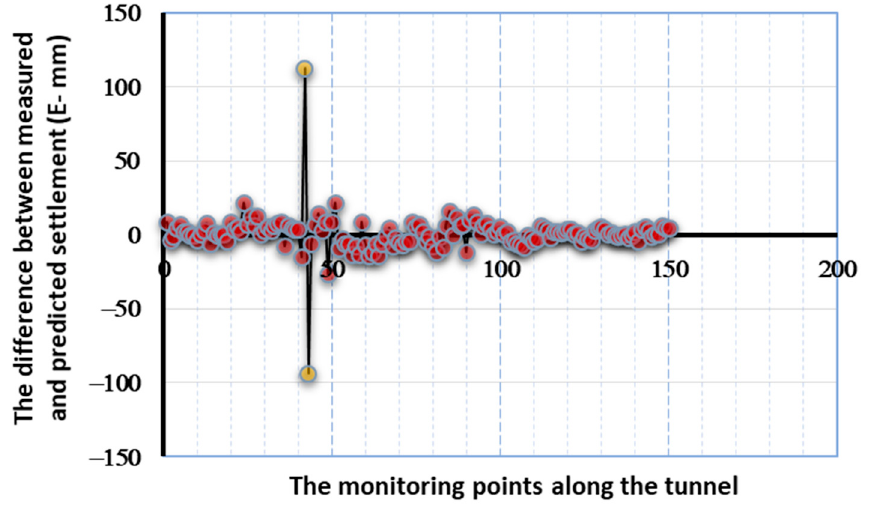
Figure 12. The difference between measured and predicted Figure 12. The di ff erence between measured and predicted se tt lement.